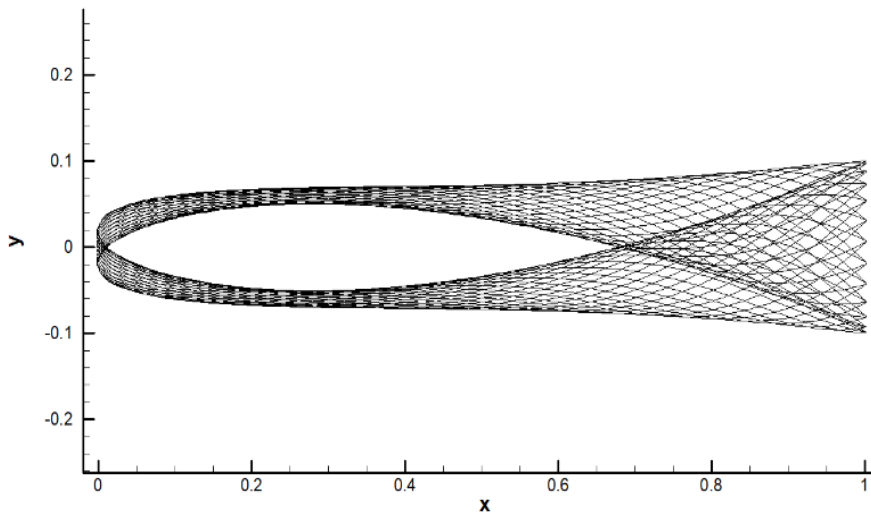
Figure 7. Length and swing range of the fish-like robot.